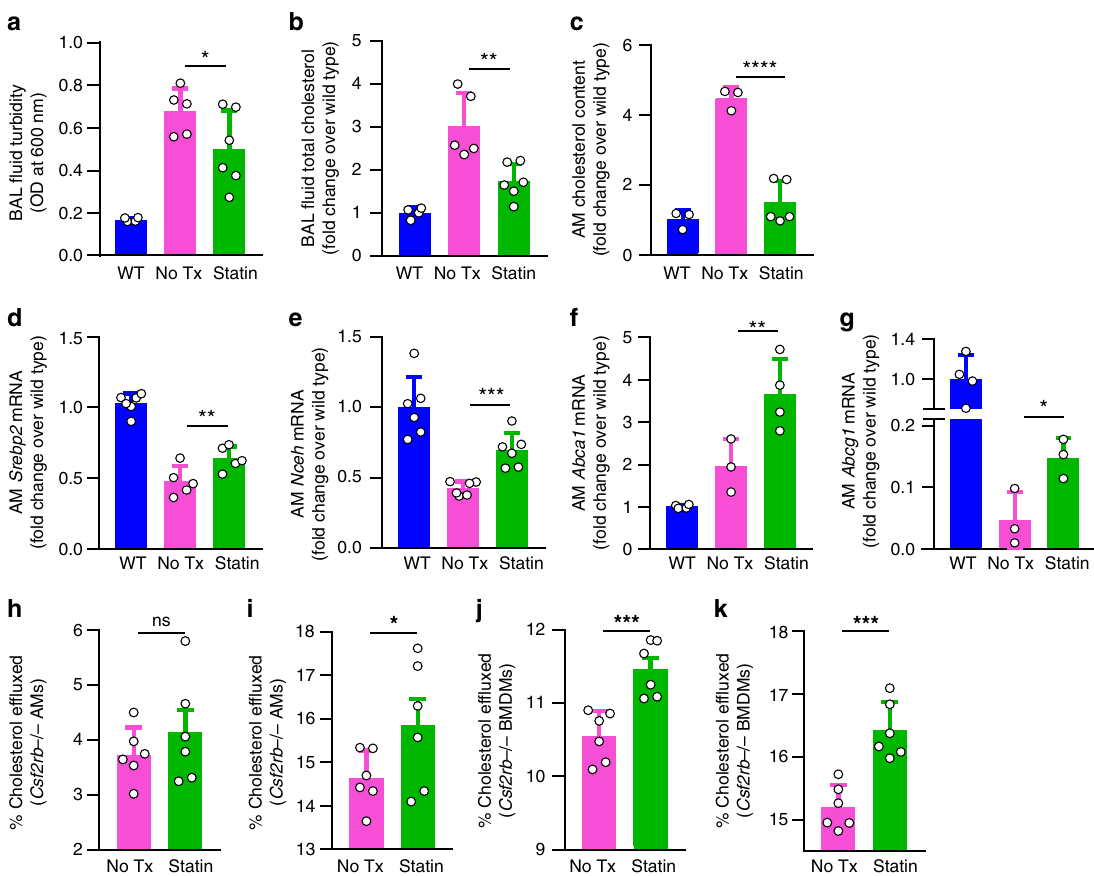
Fig. 3 Statin therapy improves cholesterol ef fl ux from macrophages and ameliorates PAP in Csf2rb − / − mice. a – g Mice received oral statin therapy for 6 weeks or untreated age-matched Csf2rb − / − or wild type (WT) mice. Disease severity evaluated by bronchoalveolar lavage a turbidity and b total cholesterol. c Alveolar macrophage cholesterol and mRNA levels for Srebp2 d , Nceh e , Abca1 f , and Abcg1 g . Cholesterol ef fl ux capacity of Csf2rb − / − AMs ( h , i ) or BMDMs ( j , k ), treated with statin for 24 hours, measured by percentage of [ 3 H]-cholesterol transferred to Apo-A1 ( h , j ) or HDL ( i , k ). Data are mean ± SD (3 – 6 mice/group), statistical differences determined by ANOVA with Bonferroni ’ s post hoc test. * P < 0.05, ** P < 0.01, *** P < 0.001, **** P <